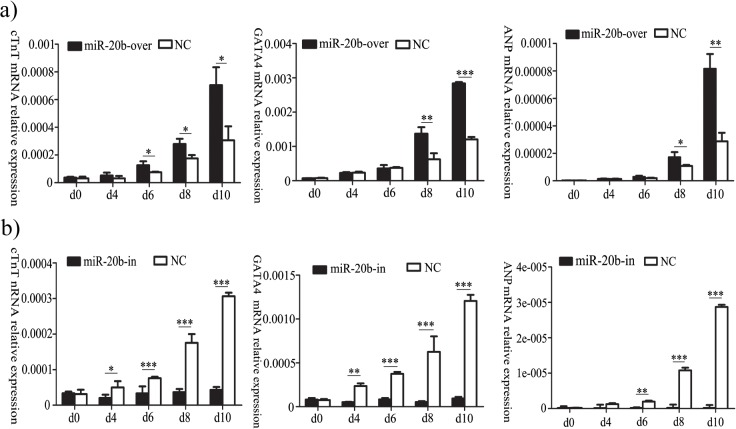
Effects of miR-20b on differentiation markers by qPCR.a): in the miR-20b overexpression cells; b): in the miR-20b silencing group. (n = 3, *: P<0.05, **: P<0.01, ***: P<0.001)